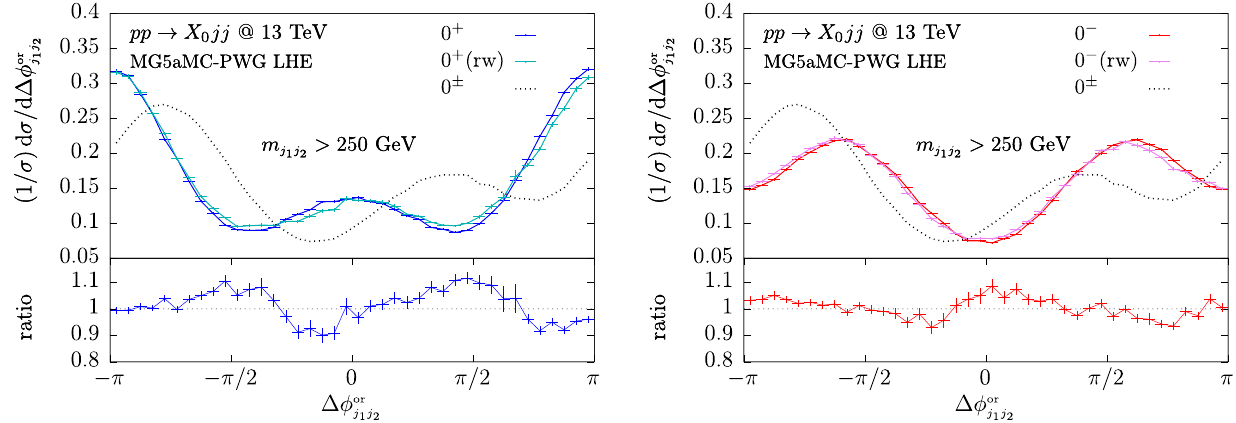
Fig. 10 Normalised differential cross section as a function of the ori- ented azimuthal separation of the two leading jets, defined in Eq. (3.12), with a cut of 250 GeV imposed on the dijet mass. On the left panel, the pseudoscalar original distribution in red, the pseudoscalar as obtained by reweighting (rw) in pink, and the scalar one in dotted blue. On the